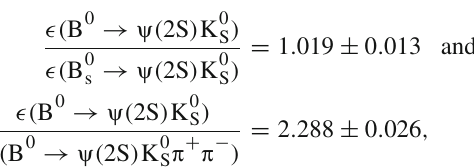
Fig. 2 Distributions of 2-body intermediate invariant masses from the + π − decay. The data distributions (black dots) are B 0 → ψ ( 2S ) K 0 S π background subtracted. Overlaid are the predictions of phase space